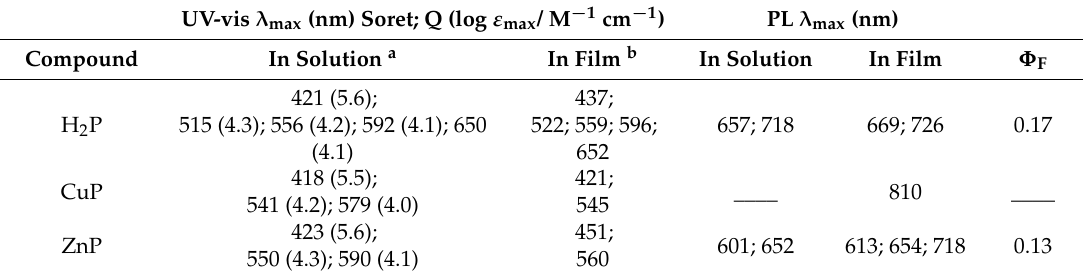
Figure 1. ( a ) UV-Vis absorption spectra of H 2 P, CuP, and ZnP in CH 2 Cl 2 , and in ( b ) solid state.